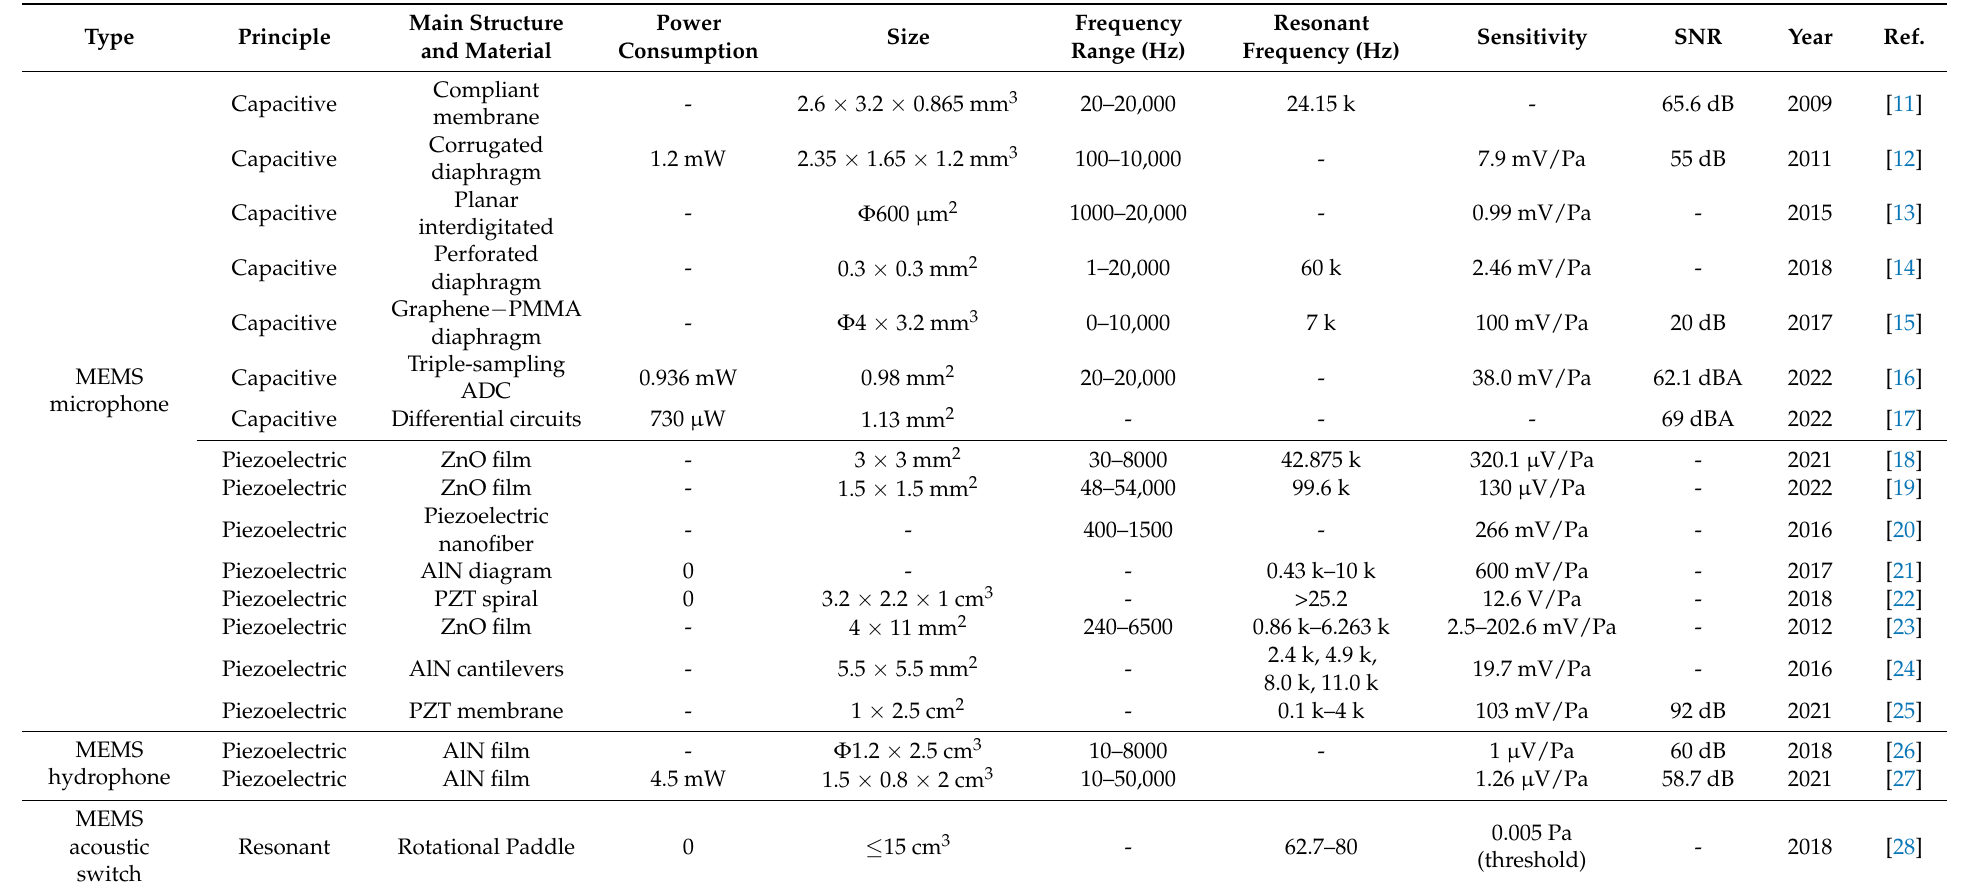
Table 1. MEMS acoustic